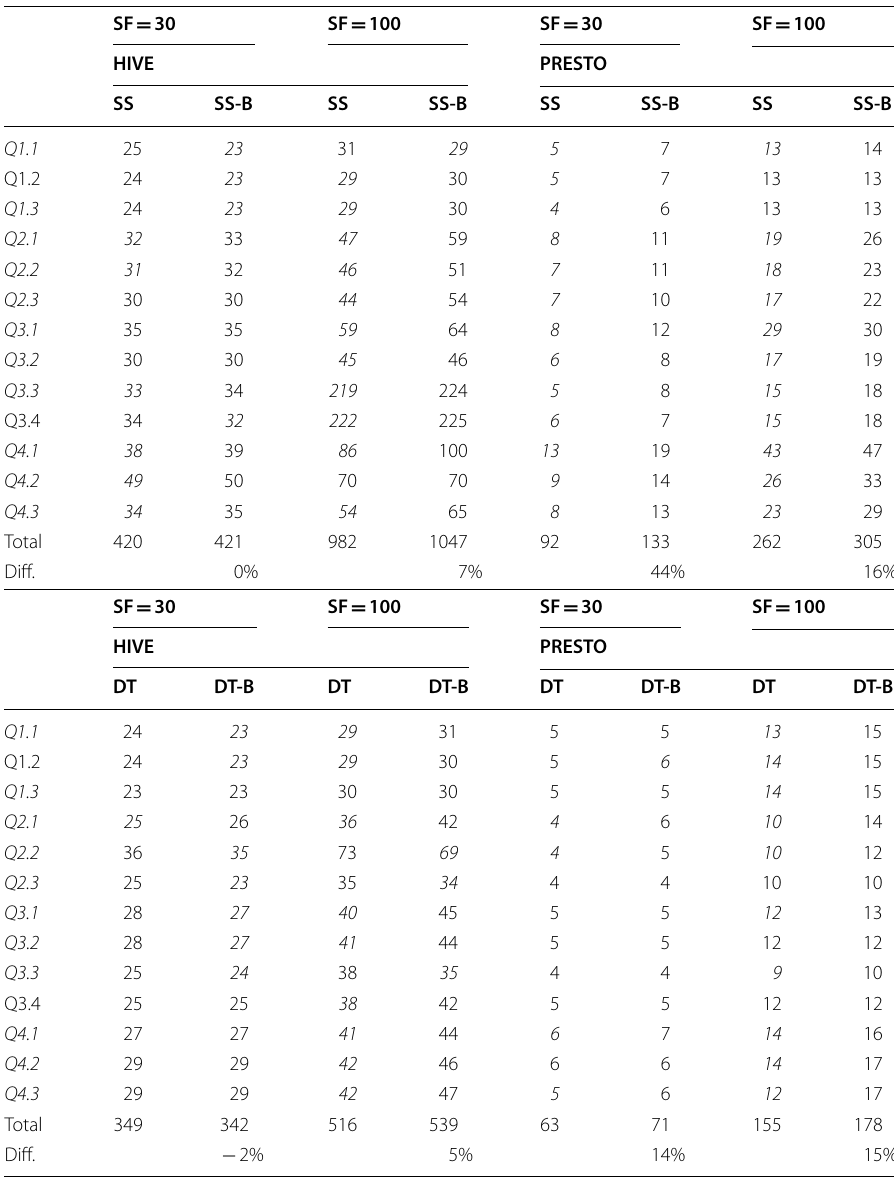
Table 4 SSB execution times (in seconds): bucketing by “Orderkey” (star schema with buckets (SS-B), denormalized table with buckets